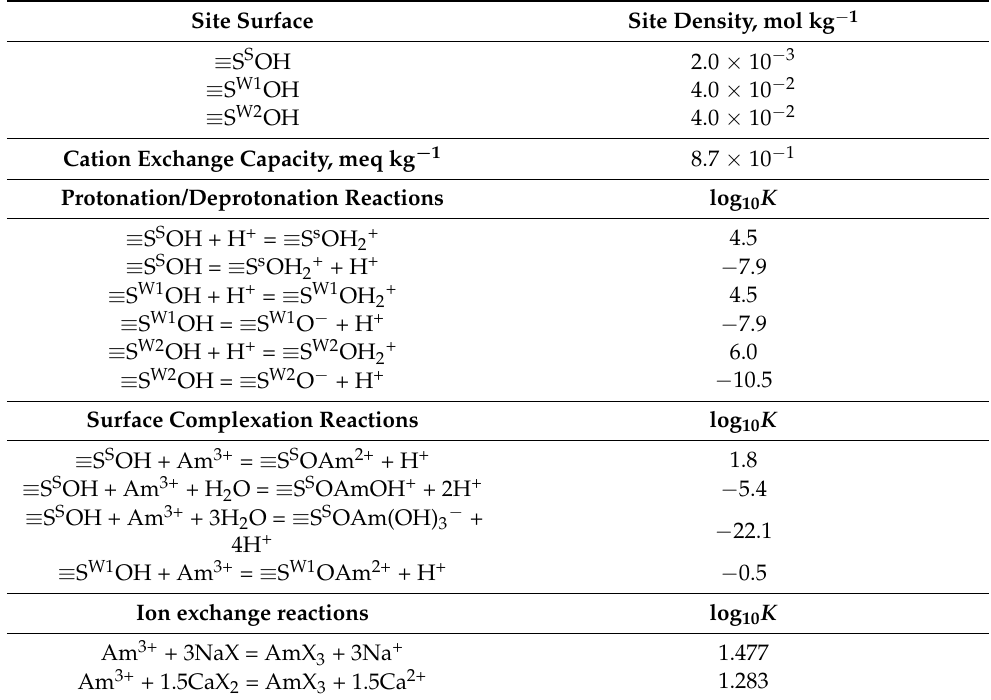
Table 6. The model parameters used for the simulation of the Am-241 sorption on the polished sample (data from